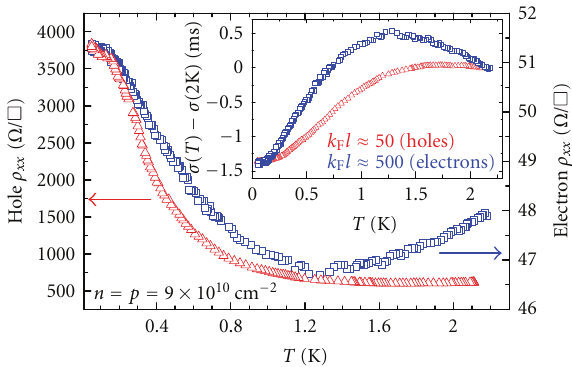
Figure 19: Resistivities of hole and electron layers versus tem- perature for n = p = 9 × 10 10 cm − 2 , down to ≈ 50mK in a dilution refrigerator. At T = 1 . 5 K, μ e = 1 . 5 × 10 6 cm 2 V − 1 s − 1 and μ h = 1 . 1 × 10 5 cm 2 V − 1 s − 1 ). (Inset) Change in conductivity relative to σ xx ( T = 2K). (Device: B138/C4-1-10nm Barrier).